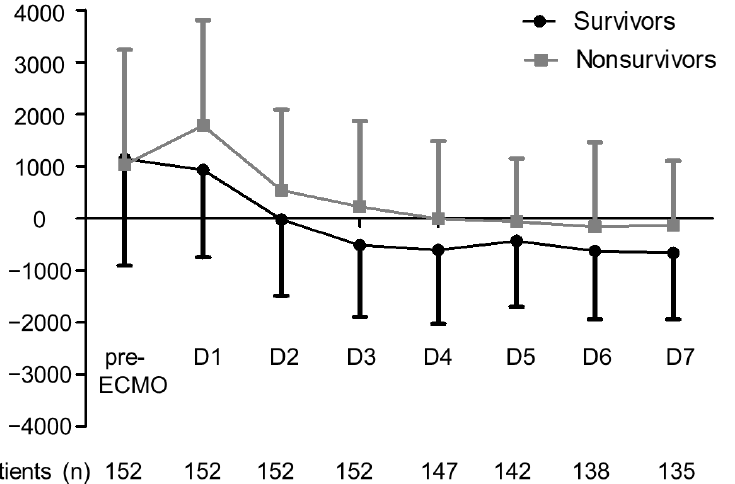
Figure 2. Mean fluid balance in survivors and nonsurvivors of severe ARDS during the first week of ECMO support. Error bars represent the mean ± standard deviation. Dark line denotes survivors, and gray line denotes nonsurvivors. * p < 0.05 comparing survivors and nonsurvivors. ARDS, acute respiratory distress syndrome; ECMO, extracorporeal membrane oxygenation.